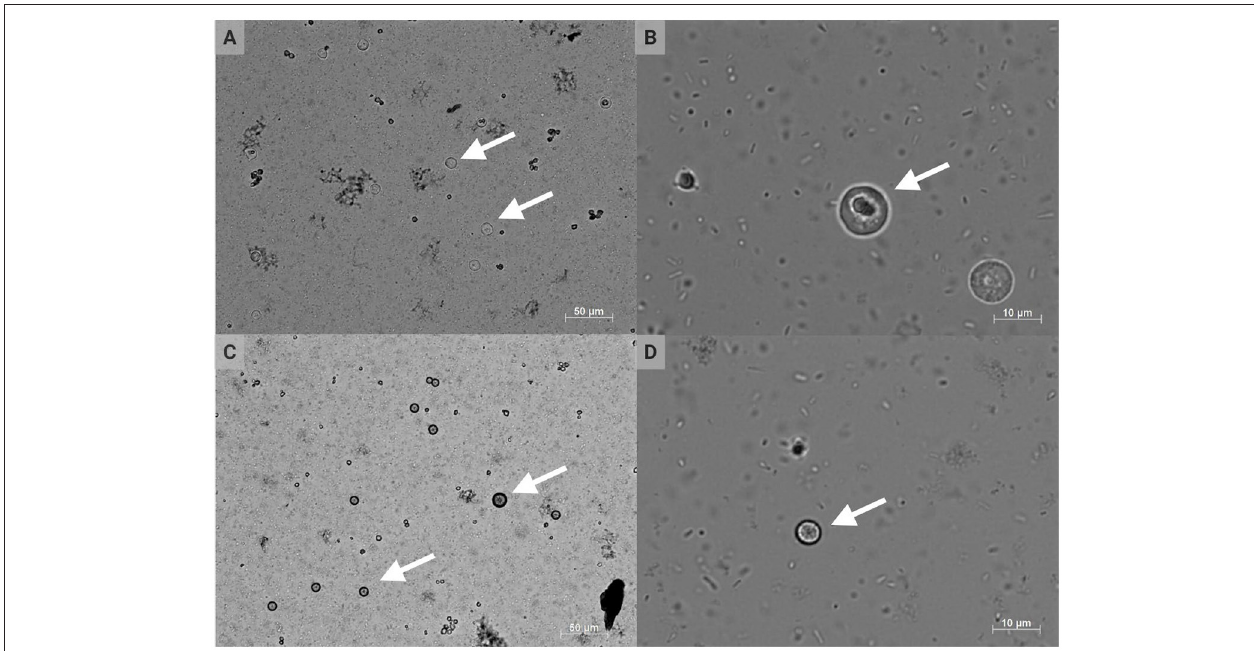
FIGURE 2 | Conventional DIC photomicrographs of Histomonas meleagridis. Amoeboid or irregular morphology of histomonads at 200 × (A) and 1,000 × ( B ) total magnification; spherical morphology of histomonads at 200 × (C) and 1,000 × ( D ) total magnification. The arrows indicate selected histomonads (Created with